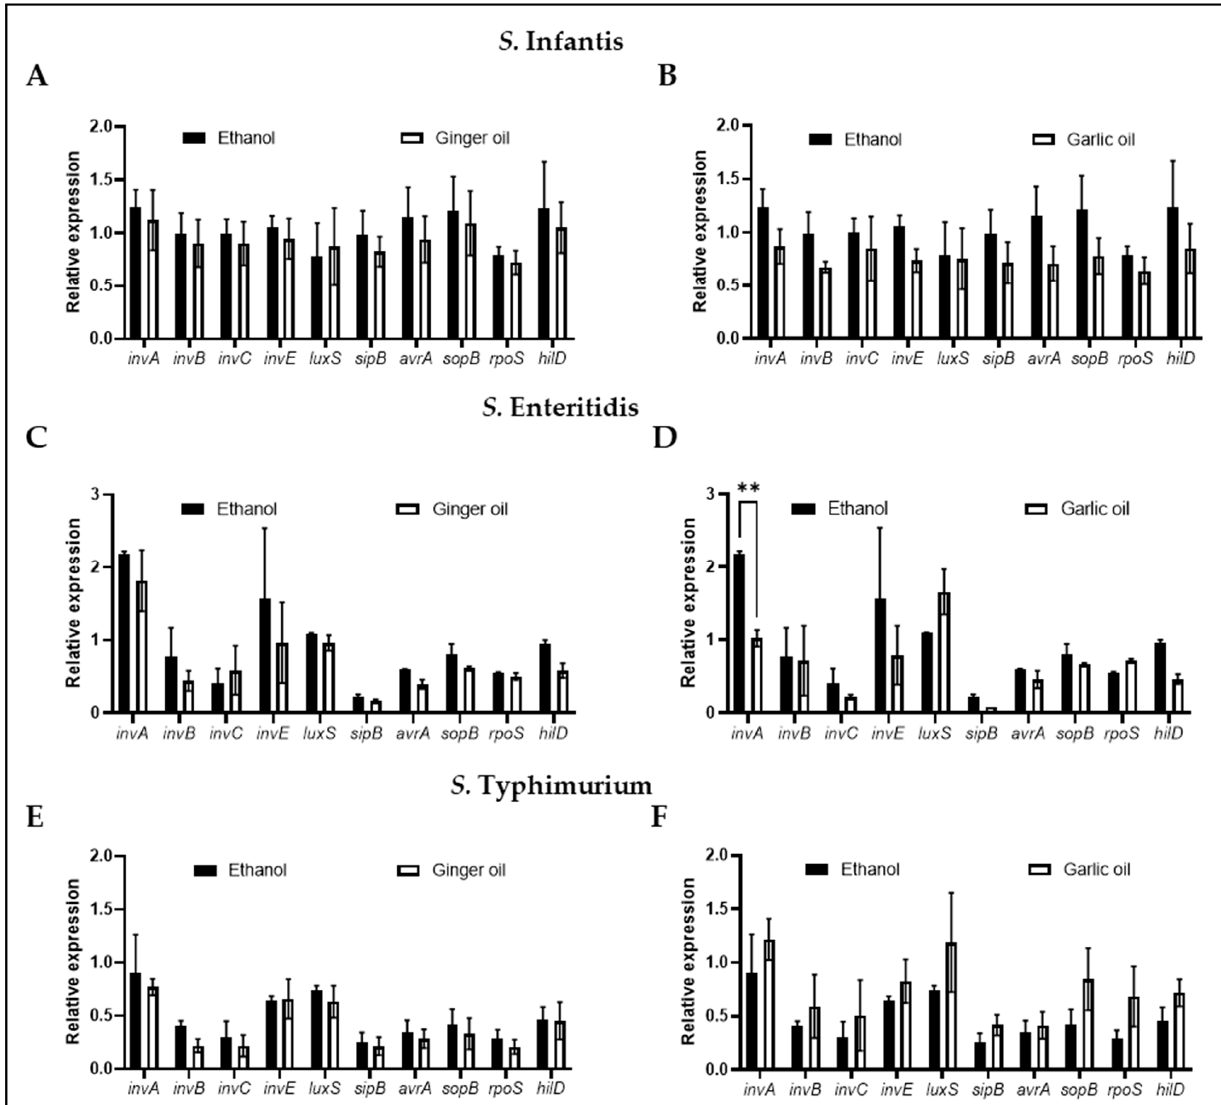
Figure 4. Effect of garlic and ginger oil on the expression of genes critical for survival and virulence was determined using qPCR. S . Infantis ( A , B ), S . Enteritidis ( C , D ), and S . Typhimurium ( E , F ) (~6.0 Log CFU/mL) were incubated at 37 °C for 4 h in the presence of the SIC of phytochemicals. 16S-rRNA served as the endogenous control. Results are averages of four biological replications (mean and STD) and were considered significant at p < 0.05 (** p <